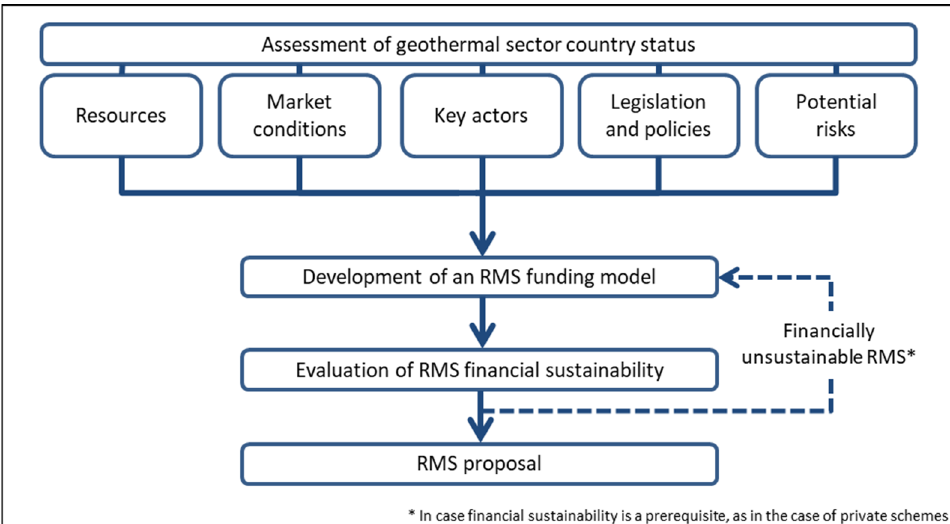
Figure 2. Process for the development of a geothermal RMS (own